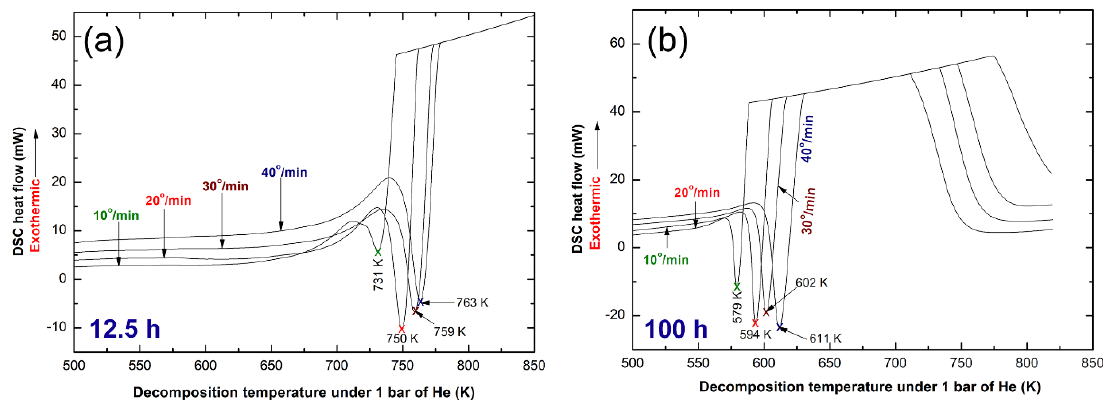
Figure 8. DSC curves obtained with different heating rates, k (10, 20, 30, and 40 °C/min) of nanocomposite MgH 2 /7 wt% a-LaNi 3 powders, rod milled for ( a ) 12.5 h and ( b ) 100 h.